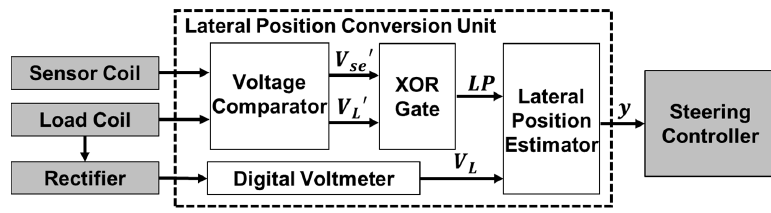
Figure 13. Block diagram showing the ACAS lateral position detection unit .